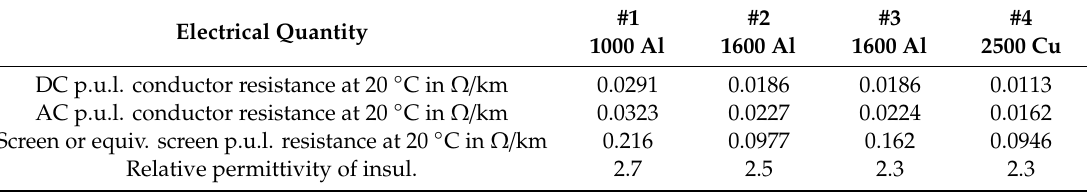
Table 5. Electrical characteristics of the four reference